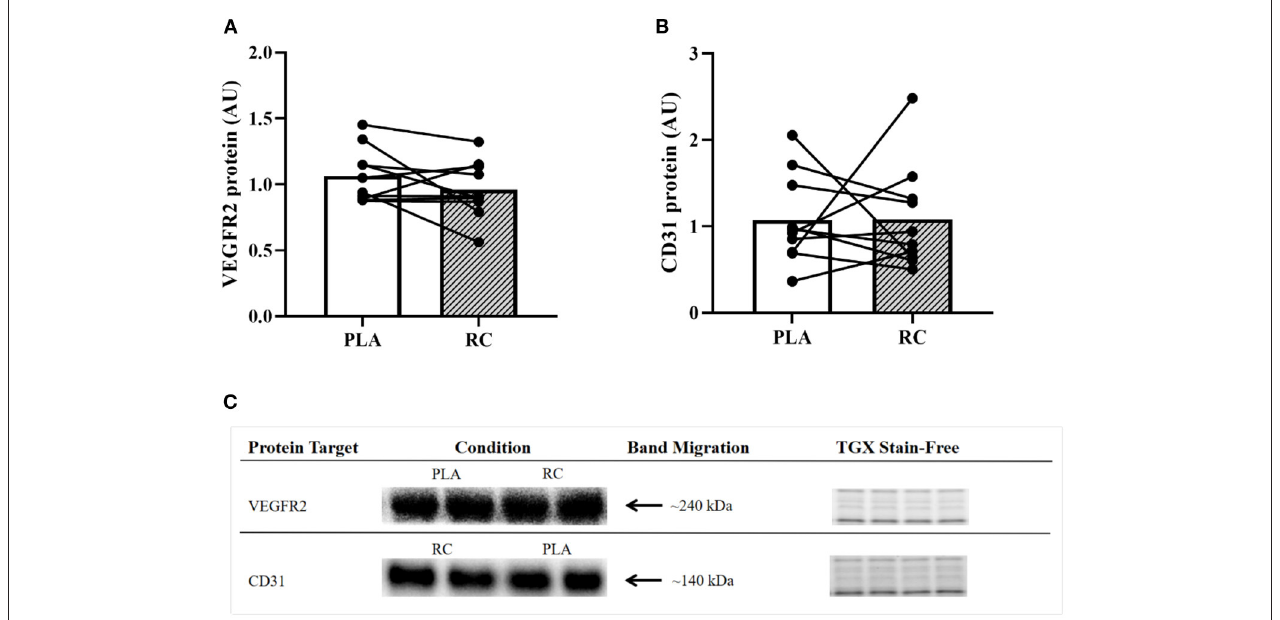
FIGURE 5 | Expression of proteins associated with angiogenic potential in skeletal muscle from early post-menopausal women following 2 weeks of twice daily supplementation with placebo (PLA) or fermented red clover extract (RC) ( n = 10). (A) Vascular endothelial growth factor receptor 2 (VEGFR2) and (B) cluster of differentiation 31 (CD31). (C) Representative western blots and the corresponding TGX stain-free